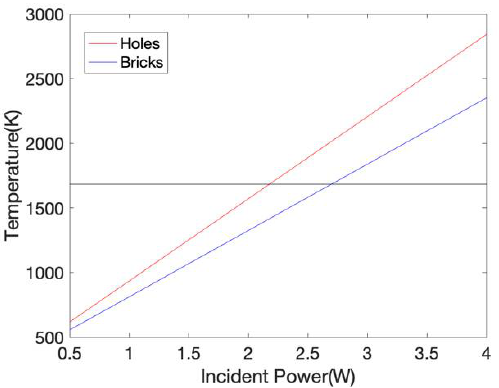
Figure 8. The maximum temperature in the metalenses with a nanobrick (blue) or nanohole (red) configuration under the illumination of different incident power. The black line marks the melting point of 1683 K of